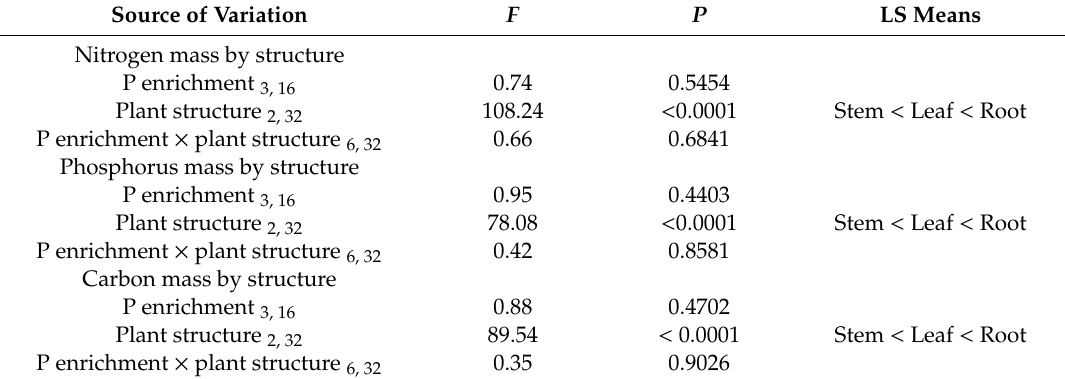
Table 2. E ff ects of P enrichment and plant structure on mesocosm plant tissue N, P, and C mass. F values and associated P values are based on linear mixed-e ff ect models that incorporated random e ff ects to account for nested measures within each